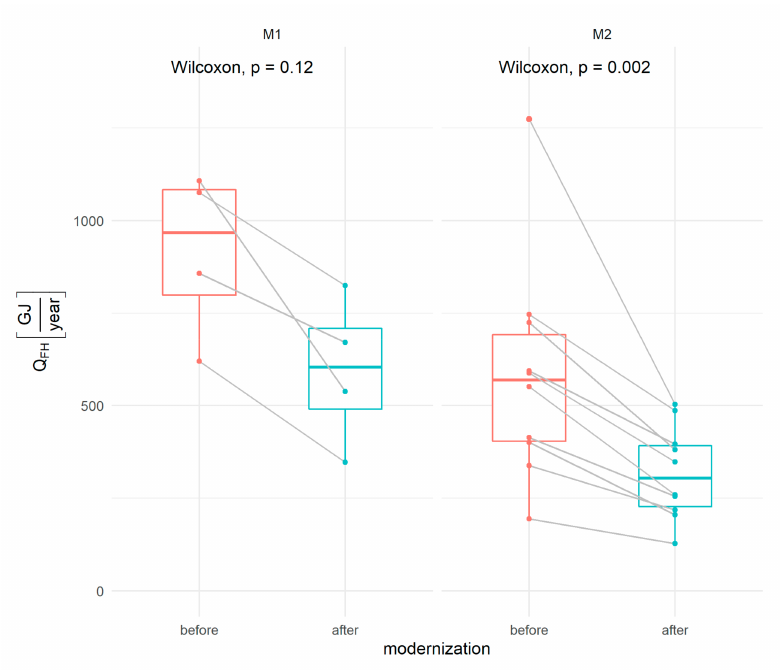
Figure 1. Decrease in final energy consumption for heating Q FH